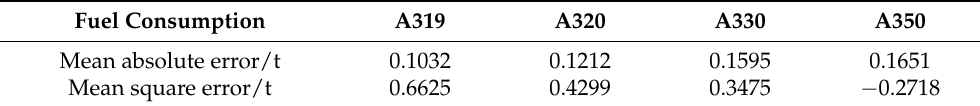
Table 2. Test the accuracy of the data set on the